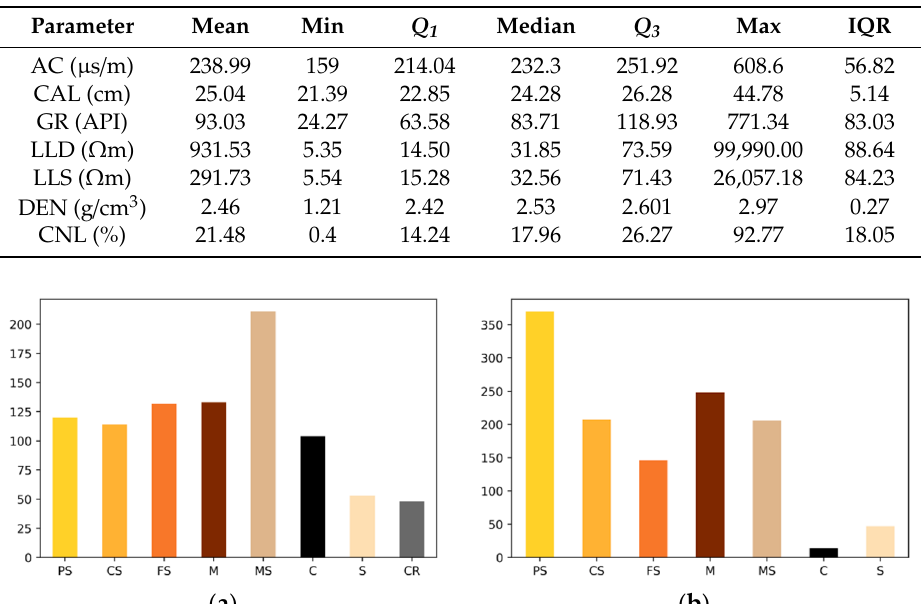
Table 1. Statistical details about the well logs in this article.